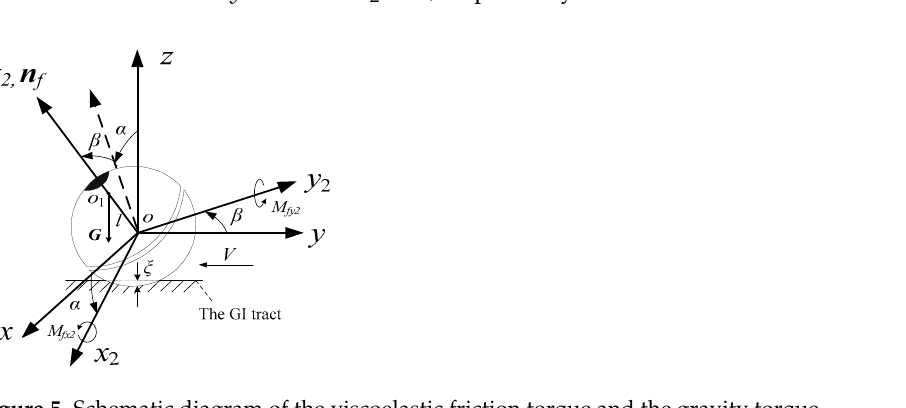
Figure 5. Schematic diagram of the viscoelastic friction torque and the gravity torque.